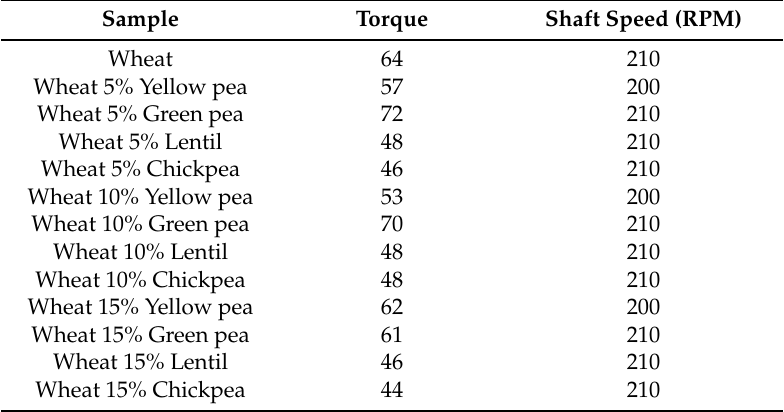
Table 1. Extrusion parameter for the